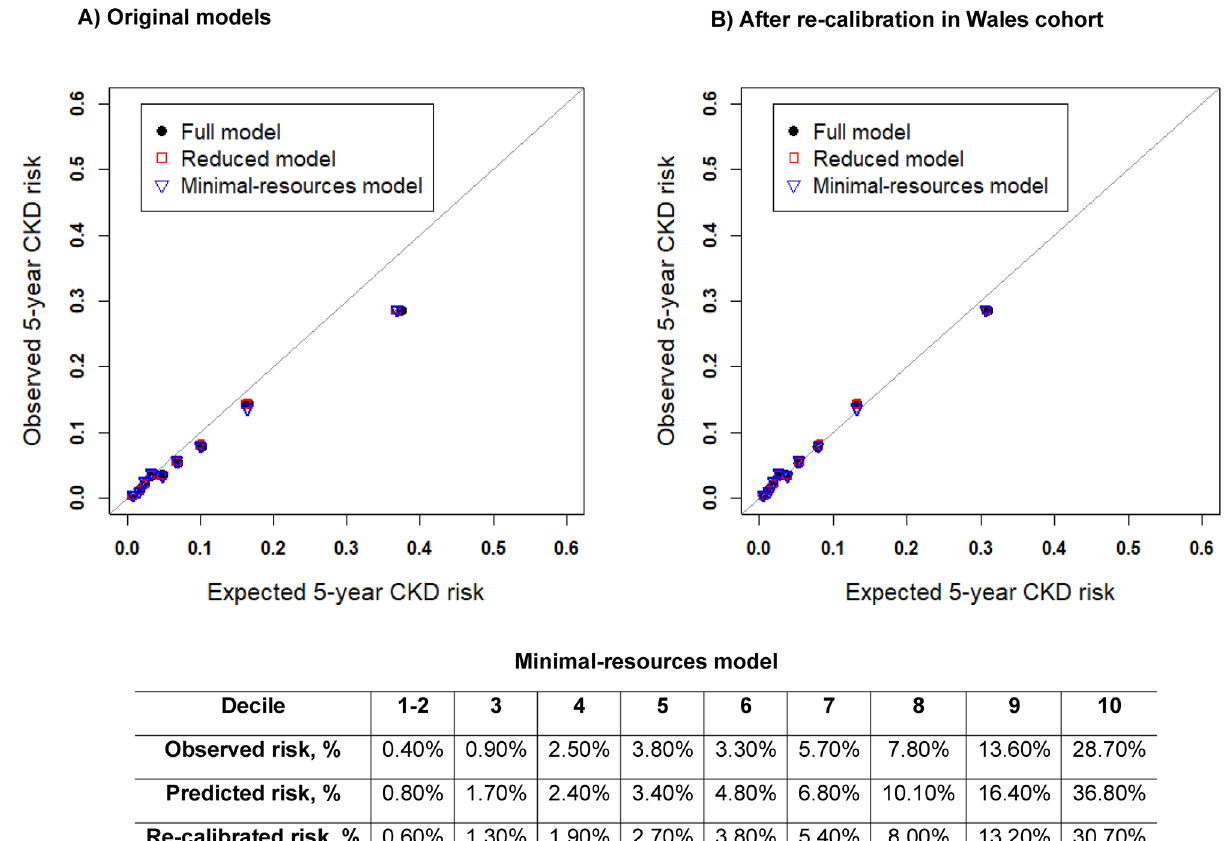
Figure 2. Calibration plots for derived models. Model predictions against observed event rates at 5-years given for 10 risk groups (collapsing first two groups due to inadequate event numbers in first two groups). Predictions from each decile were averaged, so these plots represent mean predicted risk against observed risks (KM-rates). ( A ) Represents 5-year calibration, baseline survival estimates from model development given as; 0.9824, 0.9824, 0.9828 at 5-years for the three models respectively, were used to compute risks in this group. ( B ) Represents 5-year calibration plot- after recalibration, re-calibrated baseline survival estimates given as; 0.9863,0.9860,0.9864 for full, reduced and minimal resources model respectively. Raw risk percentages provided below the plots for the minimal resources screening will enrich the proportion of positive predictive cases relative to not using this model. The hazard ratios between risk groups (Table 3) were reasonably well-maintained but larger in London for the high-risk group (London; 7.53(95% CI 5.97,9.50) vs Wales 5.50(95% CI 4.08,7.41)), meaning participants in the high-risk group in London develop stage 3 CKD at more than 7 times the rate per unit time compared to the low-risk